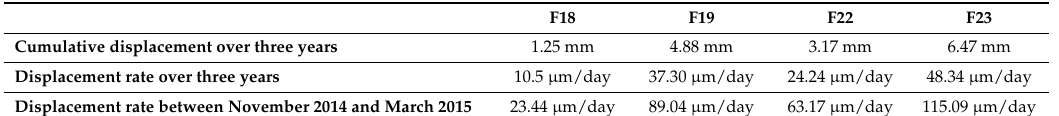
Table 1. Data for internal segments group of crackmeter.